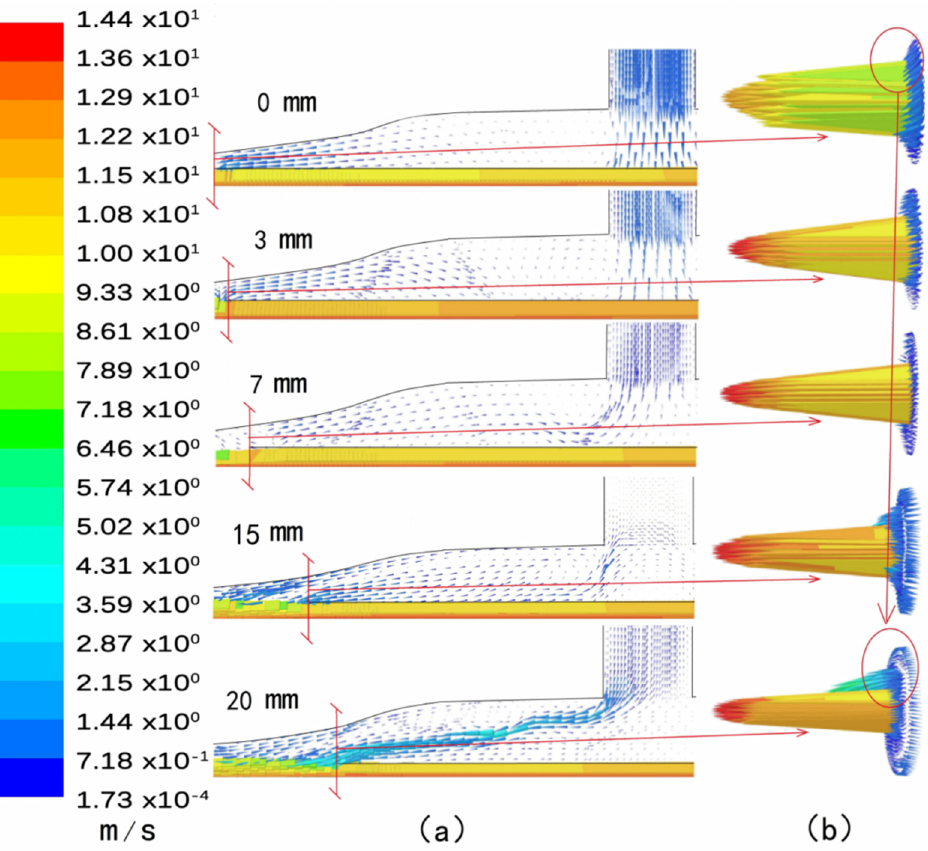
Figure 5. Velocity vector diagram of gas–water mixed phase in nozzle with different nozzle distances. ( a ) Velocity vector diagram of Y = 0. ( b ) Velocity vector diagram of the junction of mixed flow area a and mixed flow area b.